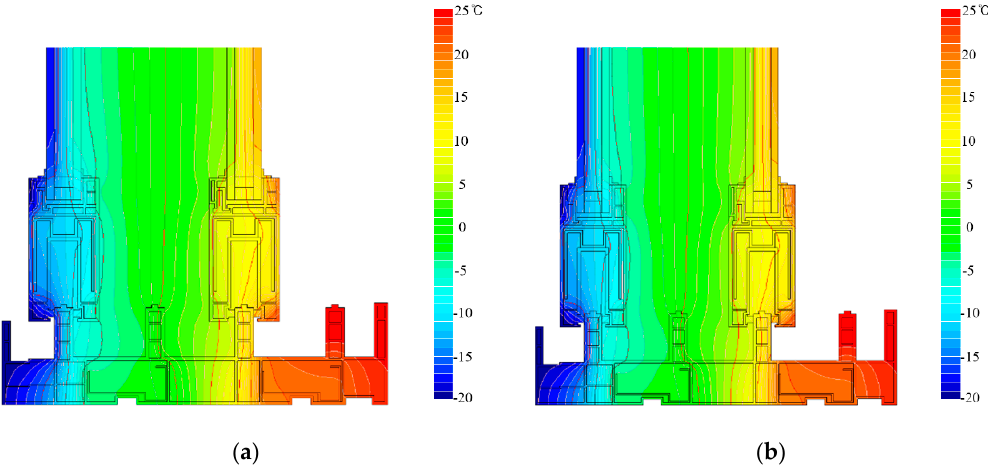
Figure 10. Temperature distributions at the glazing edge and frame: ( a ) Case 2-1; ( b ) Case 3-1.